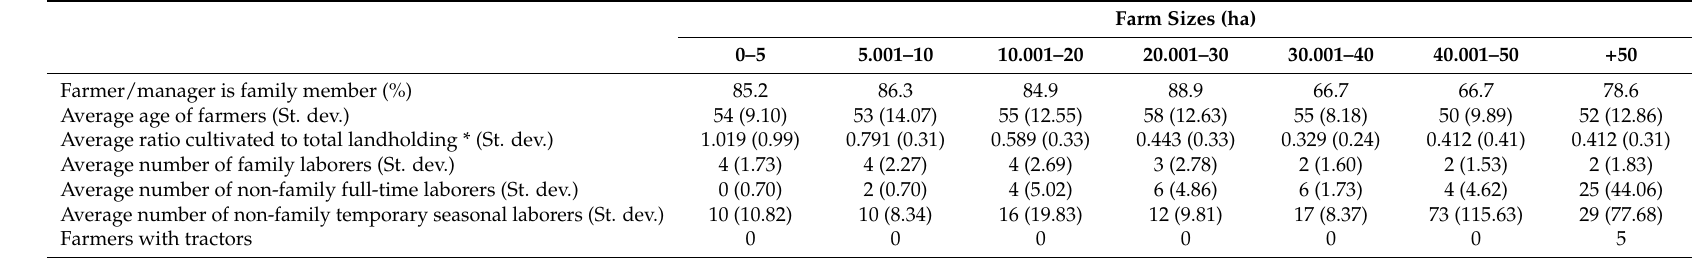
Table 4. Farm characteristics by farm size ( N = 300). Source: Authors’ medium-scale farm survey in the Mchinji, Kasungu and Lilongwe Districts undertaken by LUANAR, UP, and MSU